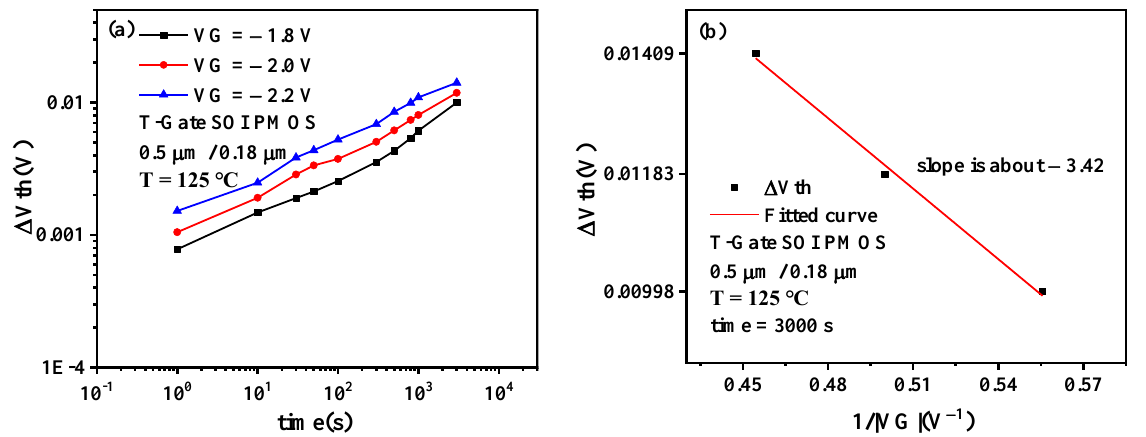
Figure 9. ( a )Time evolution of Δ V th degradation under different gate biases. ( b ) Δ V th degradation dependence on the stress bias.